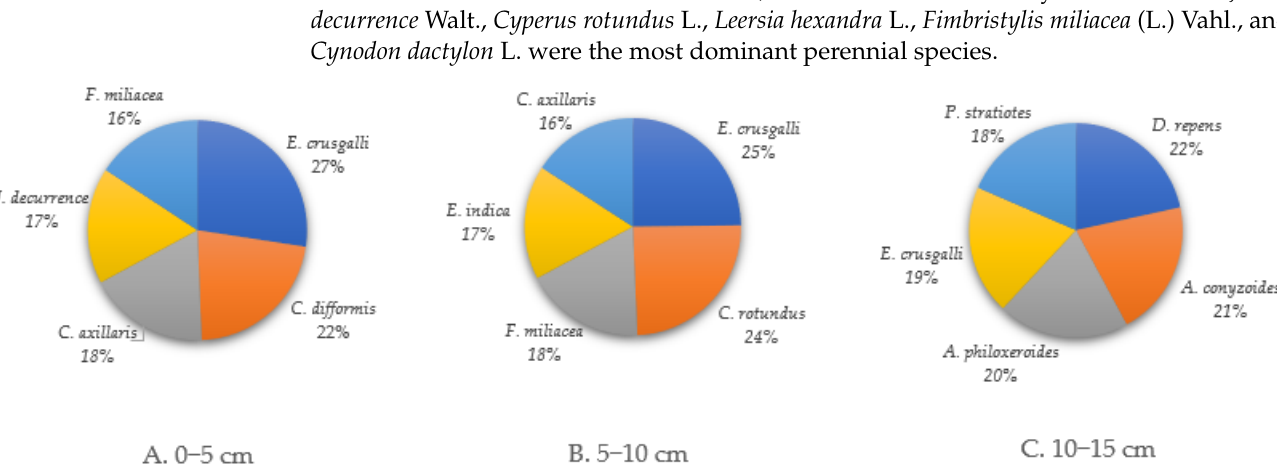
We found 30 species from the initial seed bank, of which 20 were broadleaf species, six grasses and four sedges comprising 15 annuals and 12 perennials (Table 4). The five most dominant species were Echinochloa crus-galli (L.) Beauv, C. rotundus L., Fimbristylis mil-